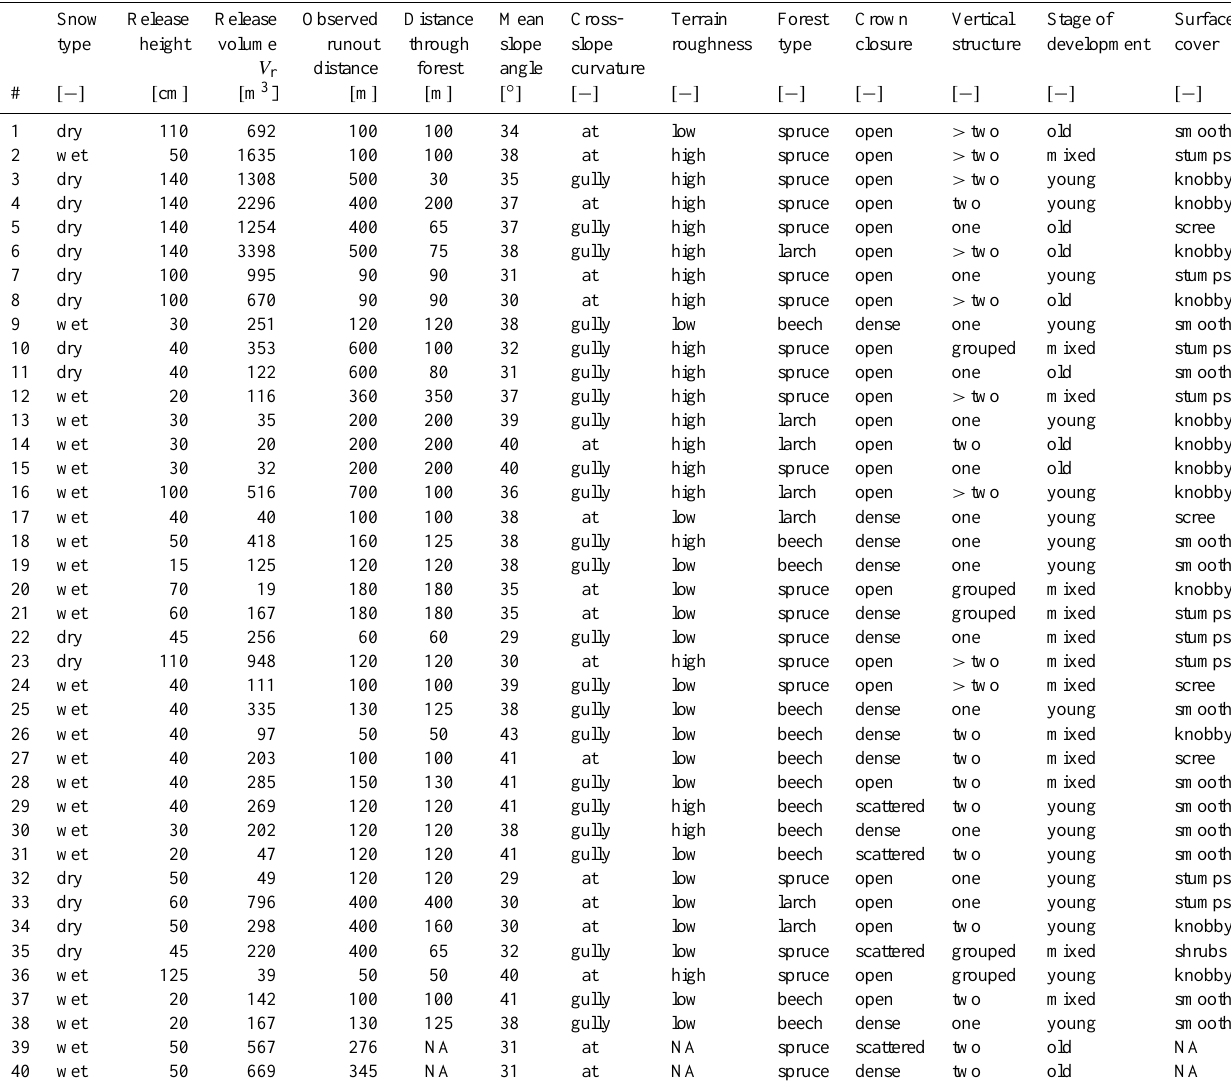
Table A1. Avalanche